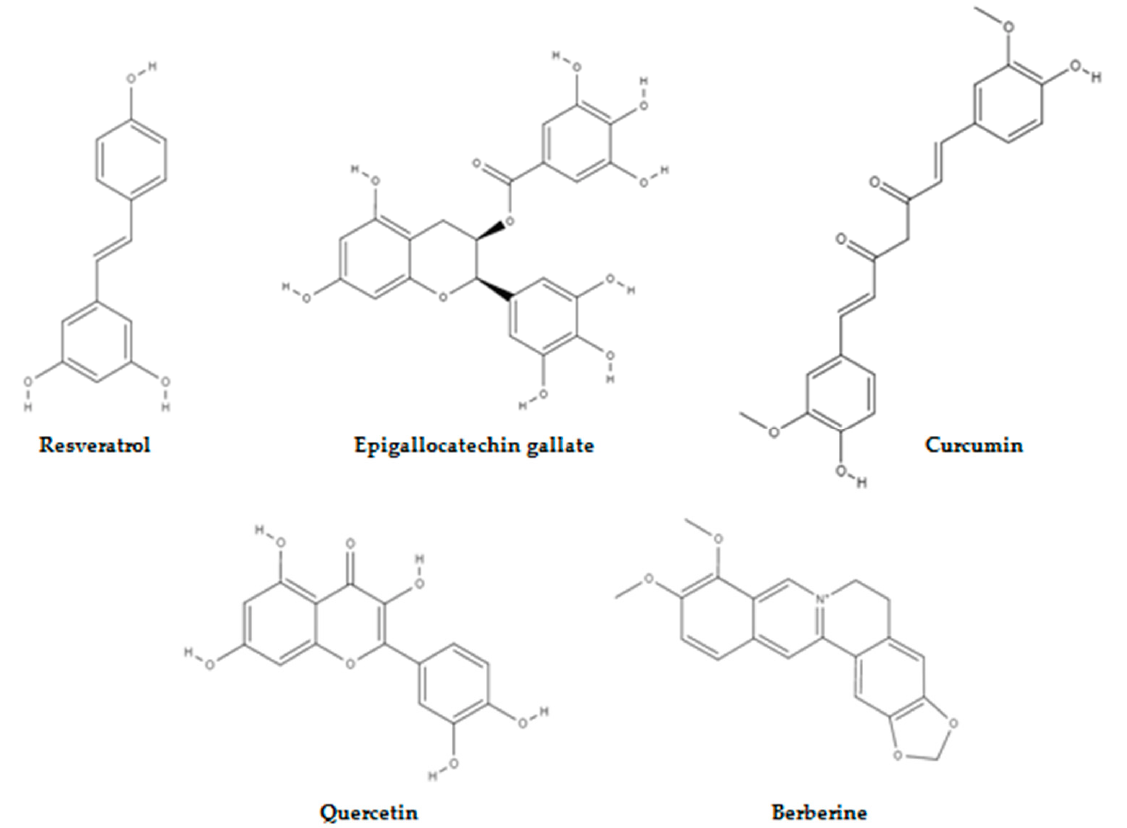
Figure 1. Naturally occurring compounds that target aberrant metabolism in cancer.